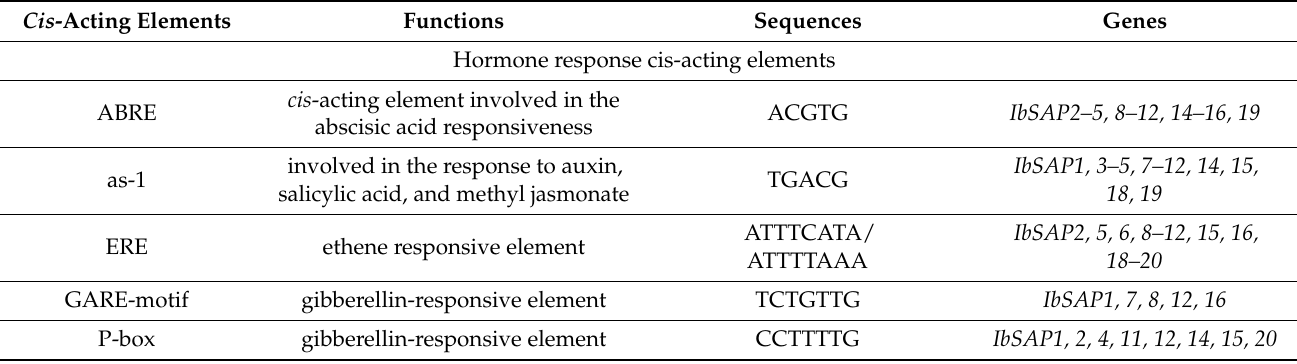
Table 2. Cis -acting elements in 2 kb promoter region of IbSAP